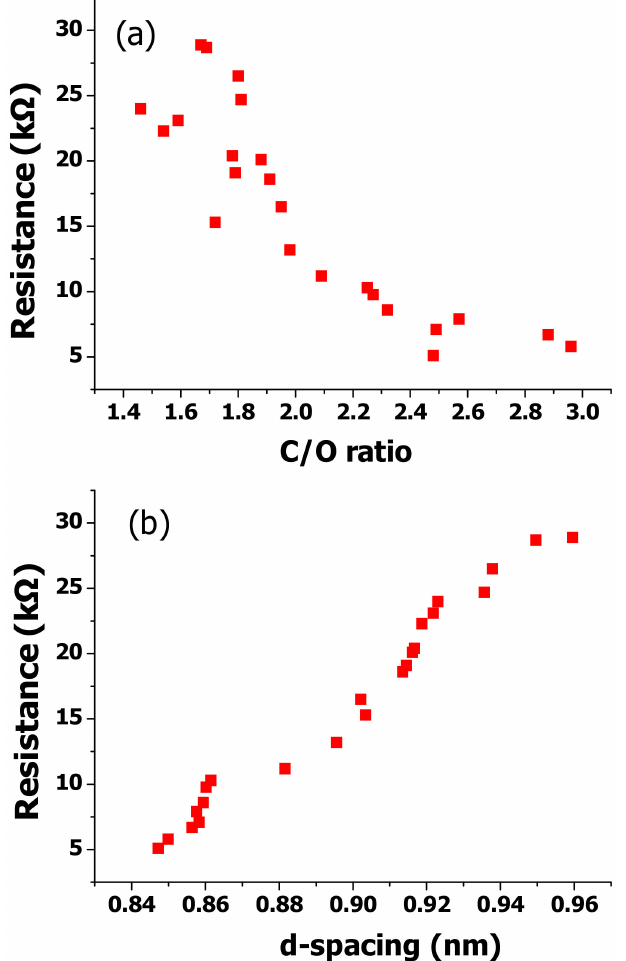
Figure 7. Electrical resistance of the synthesized EGOs versus the C / O ratio ( a ) and the d-spacing ( b